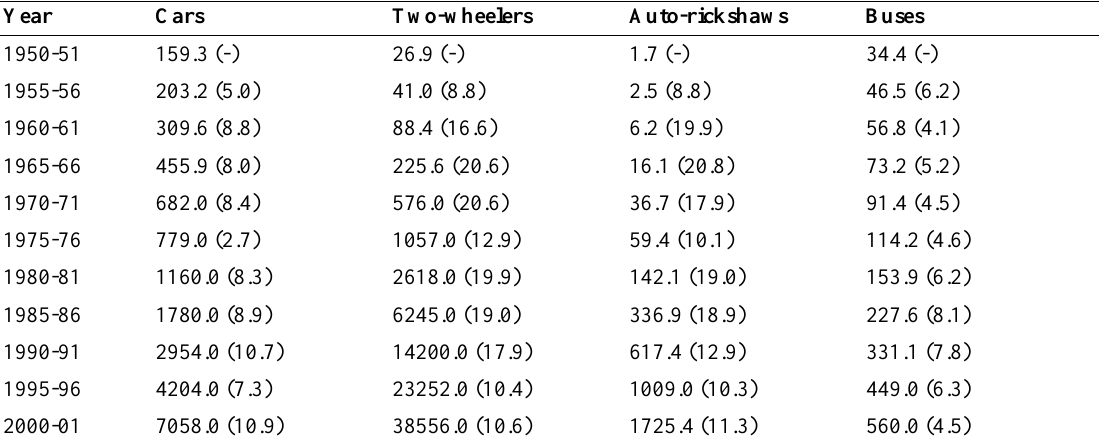
Table A1. Passenger vehicle population in thousand and its compound annual growth rate in % age since previous period (in parentheses)